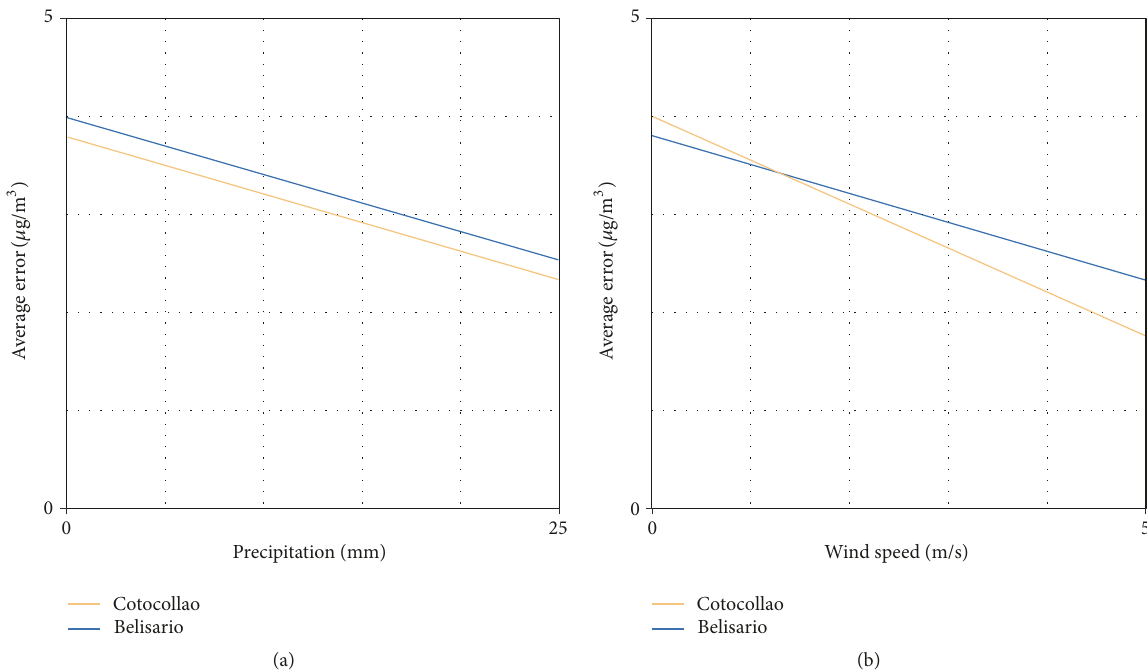
Figure 8: Decrease in average prediction error with increasing parameter values (precipitation and wind speed) for Cotocollao (orange) and Belisario